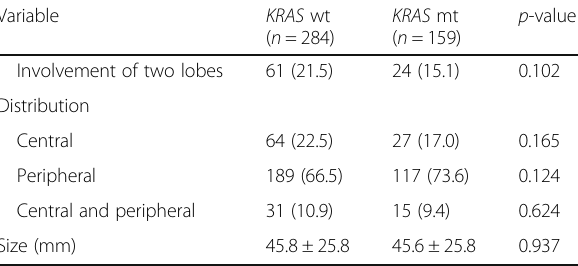
Table 6 Associations between clinicopathological features and KRAS mutational status